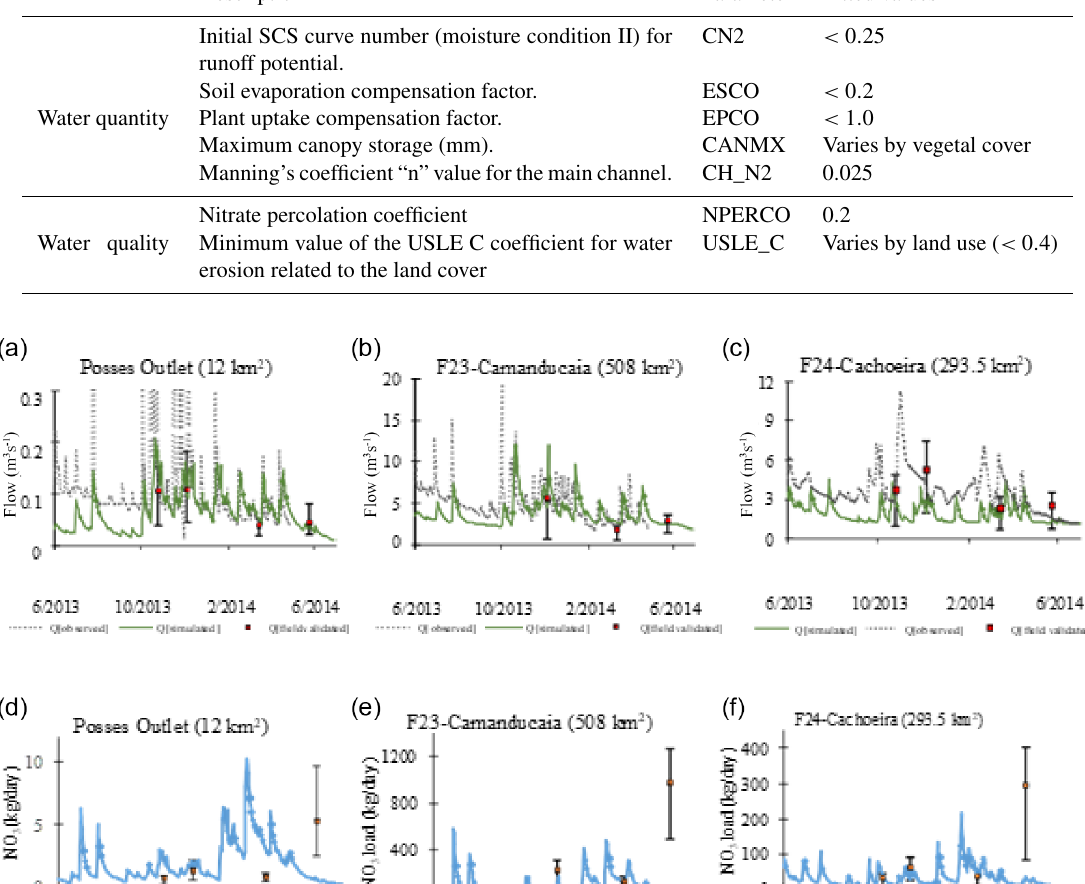
Table 3. Calibrated SWAT parameters in the headwaters of the Cantareira water supply system. SCS is related to the method developed by the Natural Resources Conservation Service of USDA, previously named the Soil Conservation Service. USLE is the universal soil loss equation.